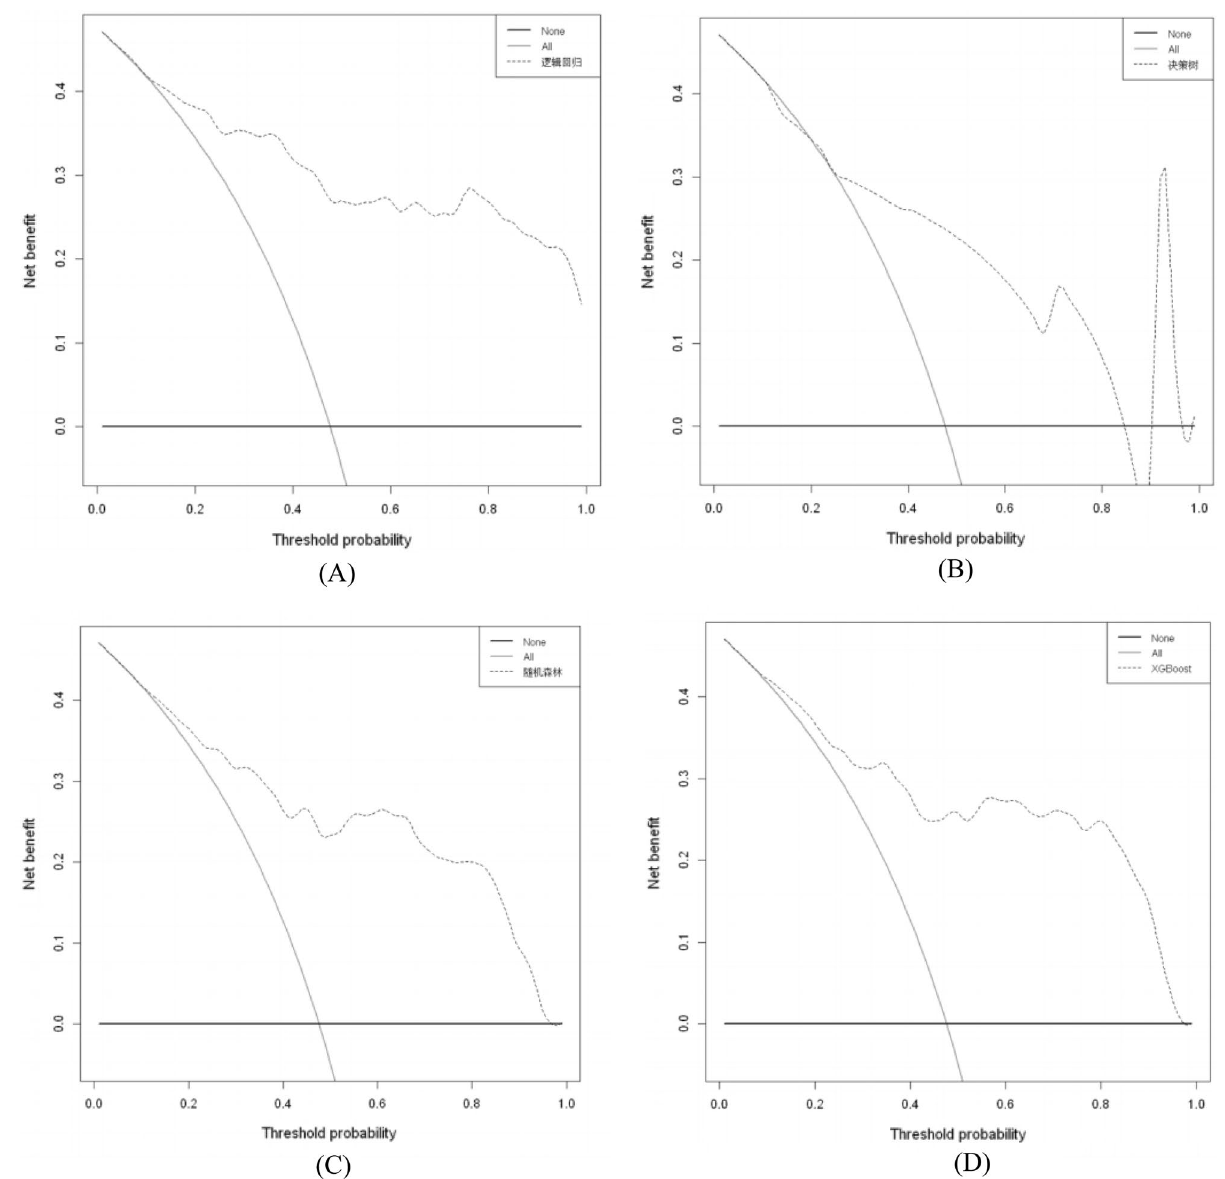
Figure 6. Decision curve analysis of machine learning models of testing set. The y-axis measures the net benefit. DCA shows the clinical usefulness of the machine learning models, according to a continuum of potential thresholds for PICS-CI risk (x-axis) and the net benefit of using the prediction model to stratify patients according to risk (y-axis). Transverse line represents the assumption that no patients have PICS-CI; oblique line represents the assumption that all patients have PICS-CI; dotted line represents the PICS-CI model). ( A ) For logistic regression, ( B ) for decision tree, ( C ) for random forest, ( D ) for XGBoost, ( E ) for neural network, ( F ) for naïve bayes, ( G ) for support vector